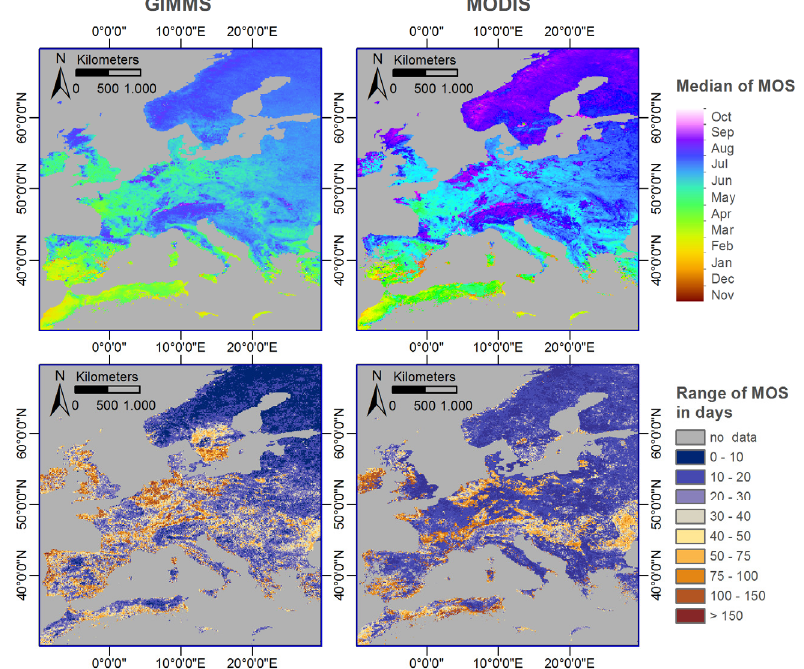
Figure 17. Spatial distribution of the maximum of season (MOS) from GIMMS ( left ) and MODIS ( right ). ( top ) median across nine years, ( bottom ) inter-annual range.